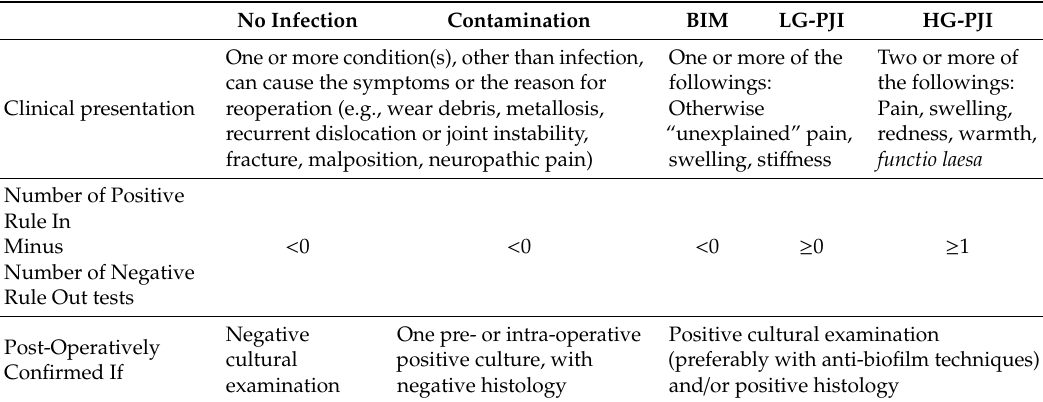
Table 2. World Association against Infection in Orthopedics and Trauma (WAIOT) Definition of Prosthetic Joint Infection